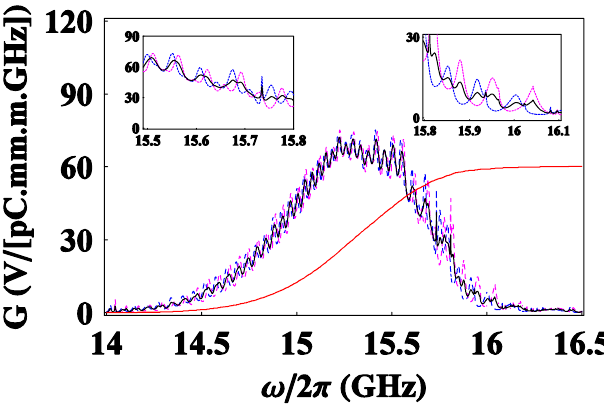
FIG. 5. (Color) Spectral functions of two interleaved accelerator structures: H60VG4SL17A/B shown by the magenta and blue dashed curves. Also shown is the summation of both spectral functions by the solid black curve.